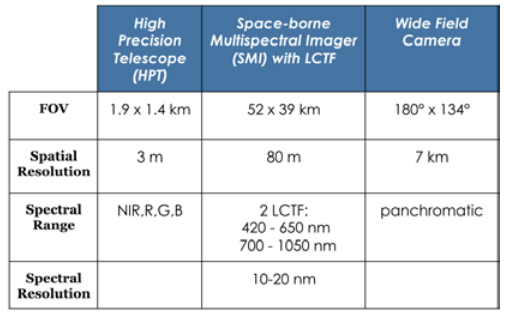
Figure 1. DIWATA